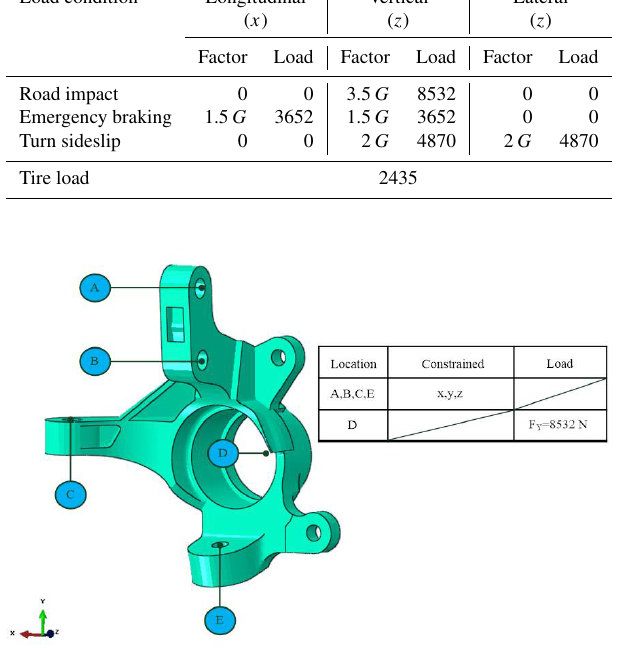
Figure 5. Boundary conditions for impact load